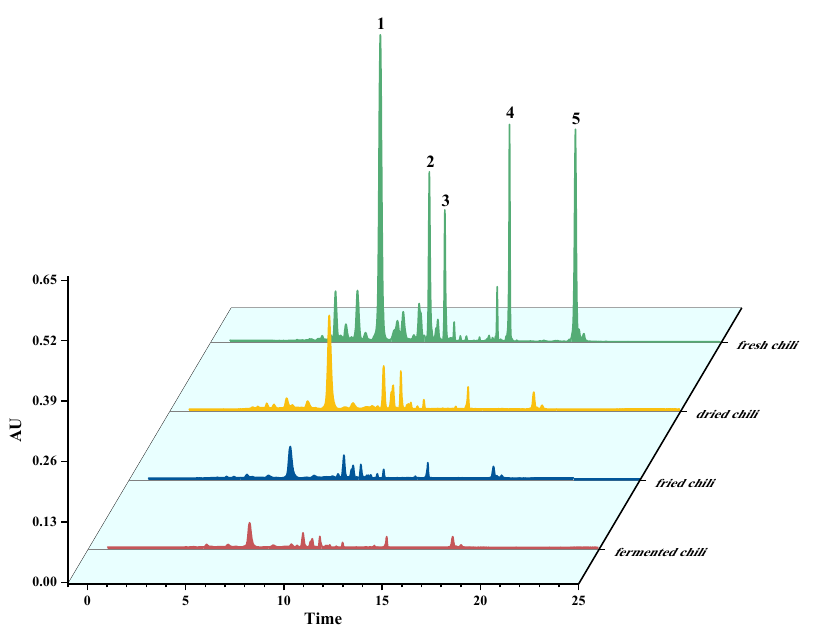
Figure 3. Chromatogram of capsanthin, zeaxanthin, lutein, β‐ cryptoxanthin and β‐ carotene.in four kinds of chili peppers and chili pepper products (1: capsanthin, 2: zeaxanthin, 3: lutein, 4: β‐ cryptoxanthin, 5: β‐ carotene).